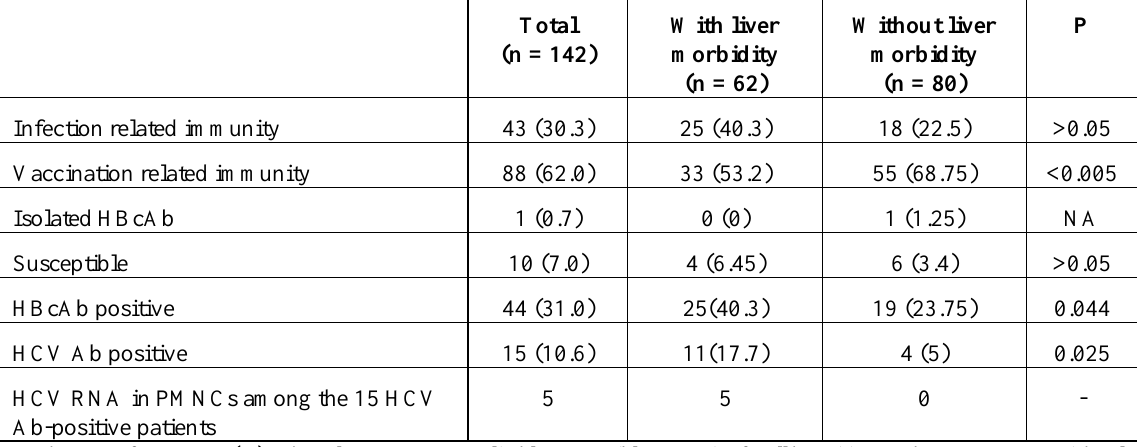
Table 4. Hepatitis markers among the studied hemodialysis patients.